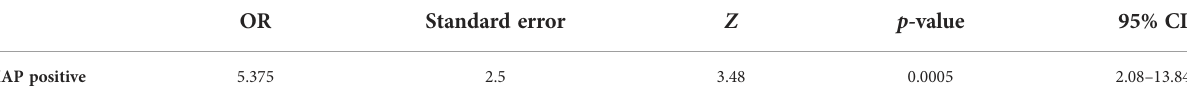
OR, odds ratio; 95% CI, 95% con fi dence